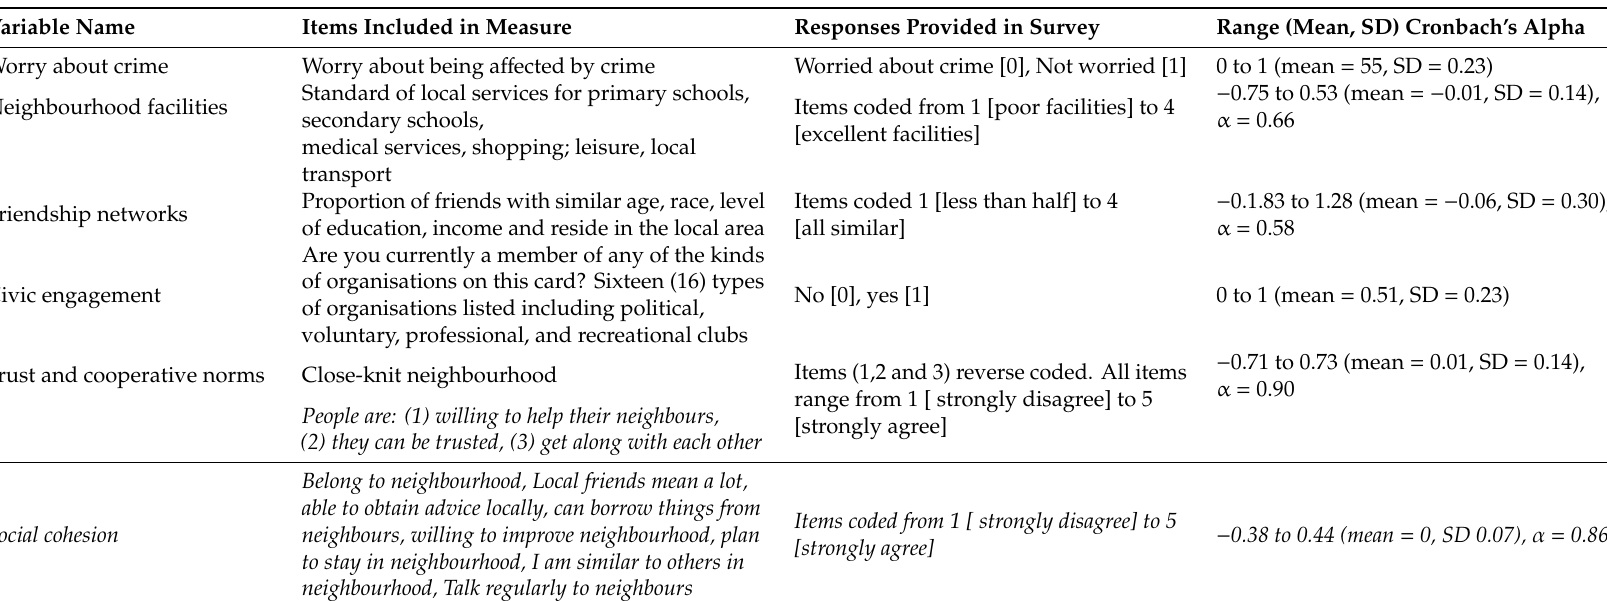
Table 1. Definition and description of survey items, and the corresponding social capital